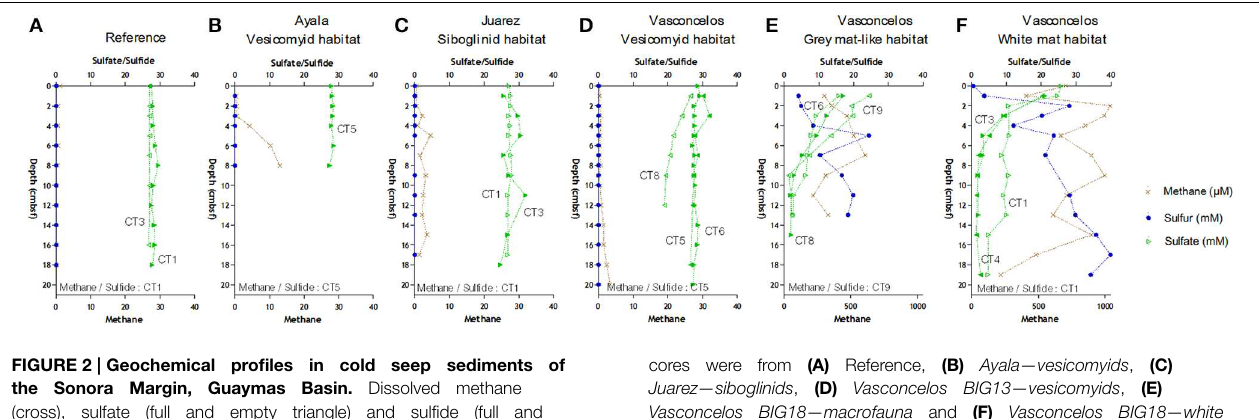
cores were from (A) Reference, (B) Ayala—vesicomyids , (C) Juarez—siboglinids , (D) Vasconcelos BIG13—vesicomyids , (E) Vasconcelos BIG18—macrofauna and (F) Vasconcelos BIG18—white mat